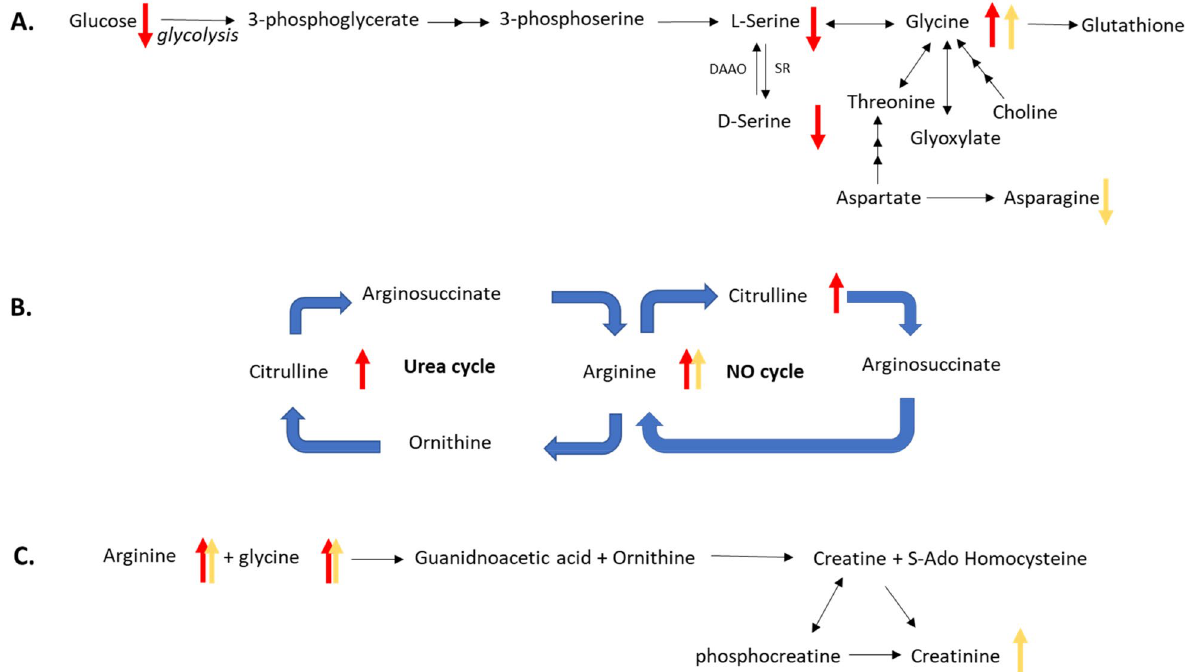
Figure 3. Overview of glycine ( A ), arginine ( B ), and creatine ( C ) metabolism in HD. Pathways with multiple metabolic changes are shown, including the urea cycle, nitrous oxide cycle and creatine synthesis. Arrows are red (plasma) or yellow (CSF), and indicate correlation with clinical state: up indicates circulating concentrations increase with progression, down indicates decrease with